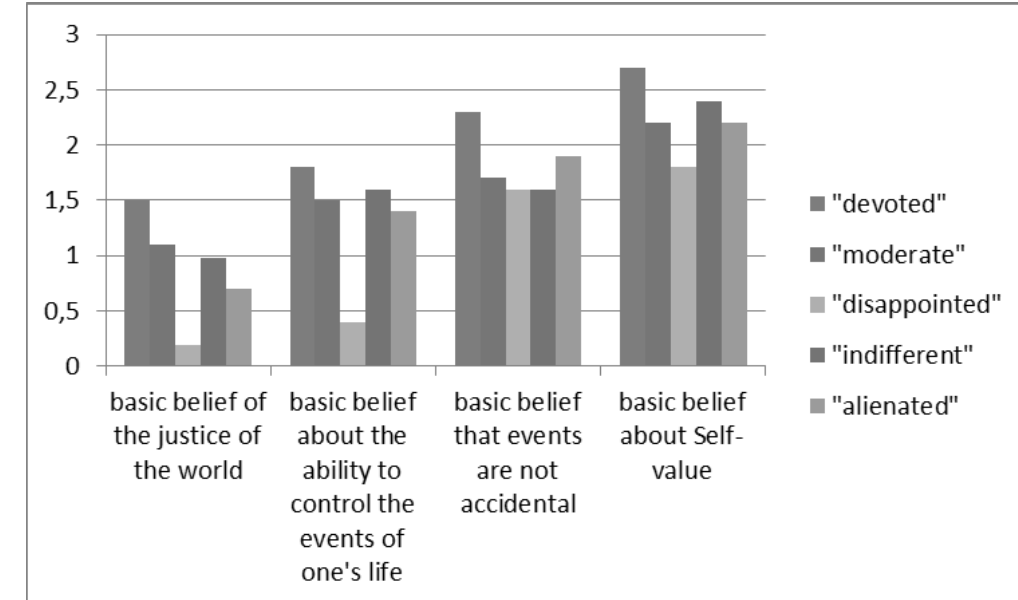
Indicators of basic beliefs of citizens with various types of civic identity Source: Own